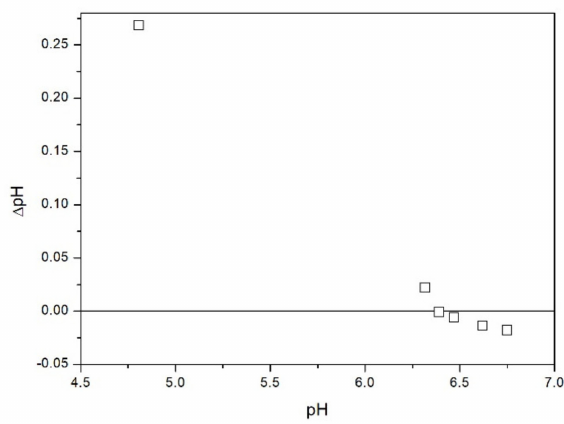
Figure 11. Shifts in the pH of TeO 2 dispersion induced by addition of